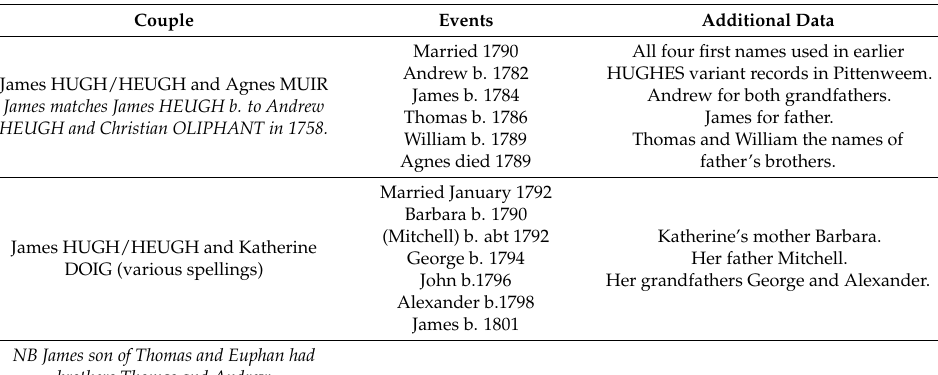
Table 3. Events for families headed by a James HUGH